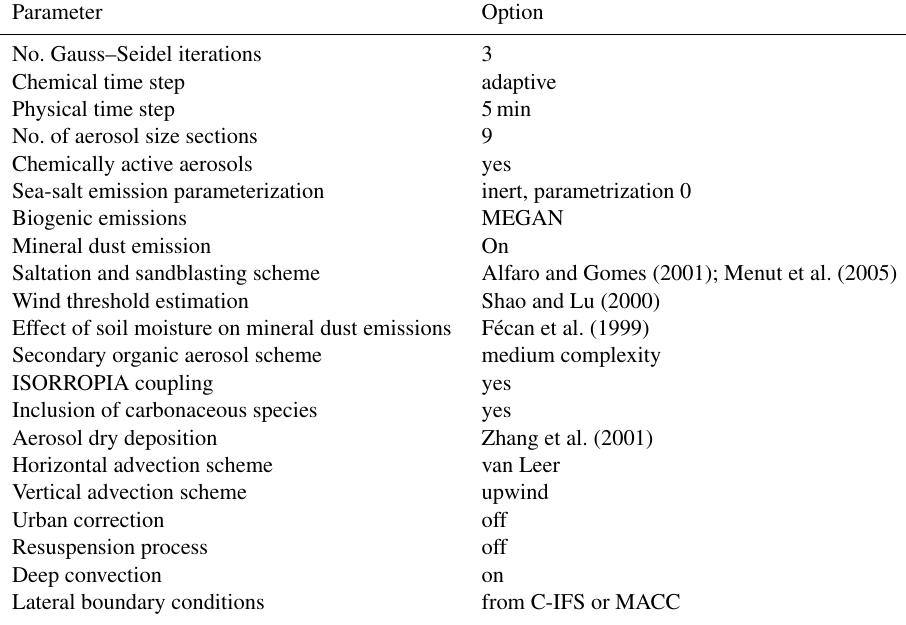
Table 2. CHIMERE parameters common to all sensitivity